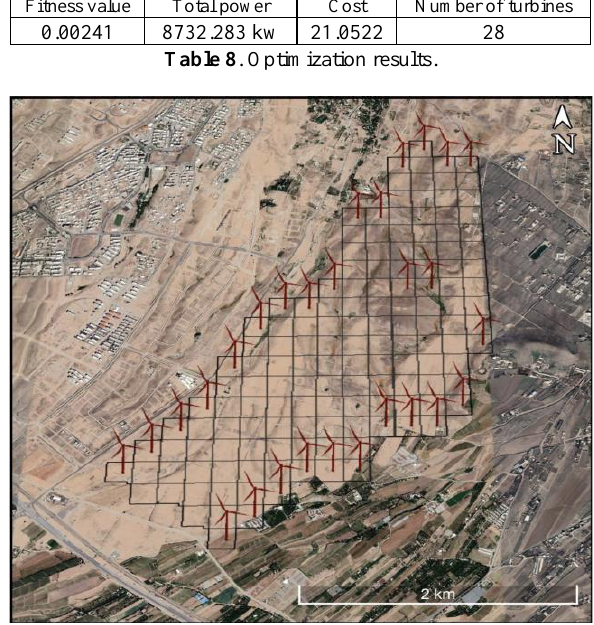
Table 8 . Optimization results.